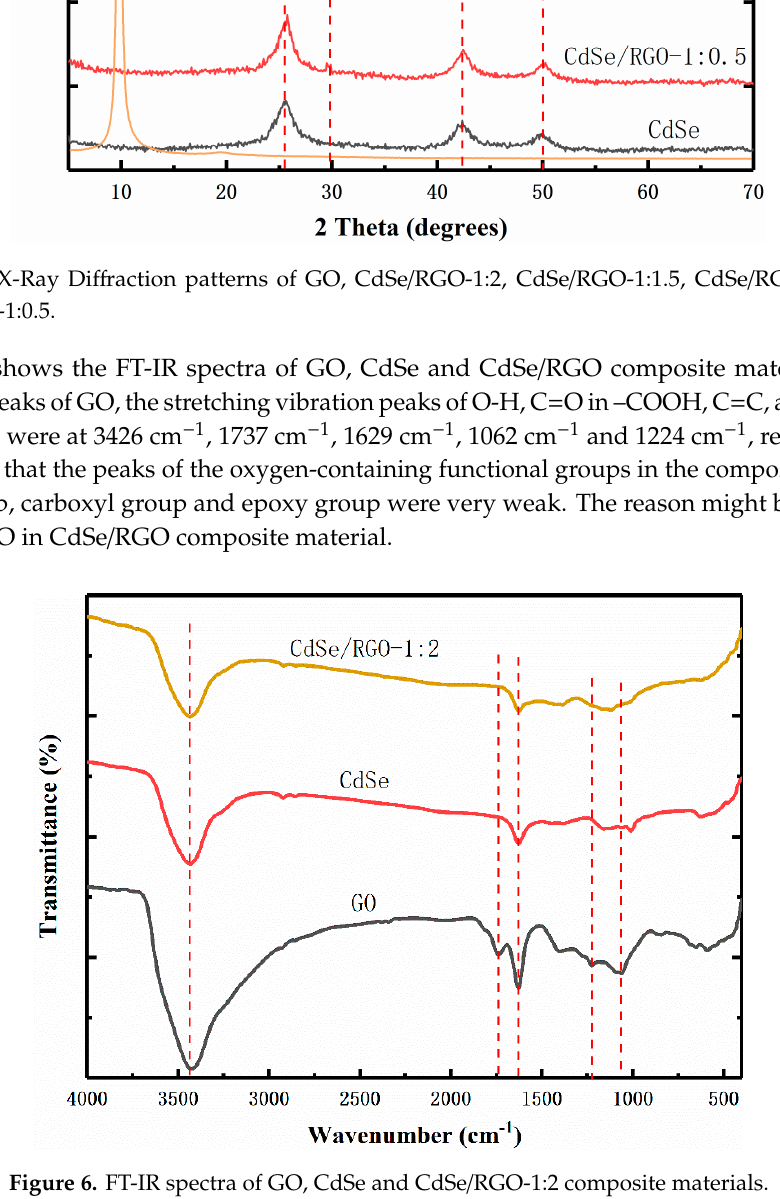
Figure 6. FT-IR spectra of GO, CdSe and CdSe/RGO-1:2 composite materials.